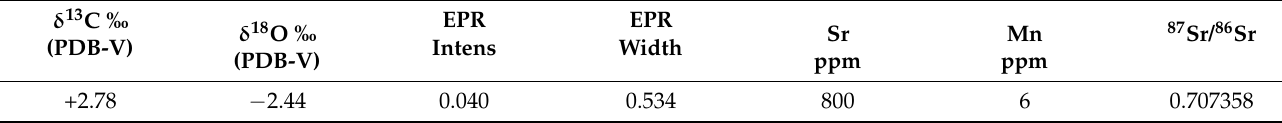
Table 2. Parameters of sample QL by conventional C and O isotopes and complementary techniques. δ 13 C